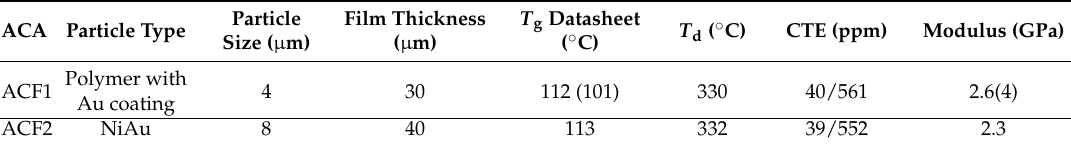
Table 1. Properties of the ACFs studied. ACA, Anisotropic conductive adhesive; T g , Glass transition temperature; T d , Decomposition temperature; CTE, Coefficient of Thermal